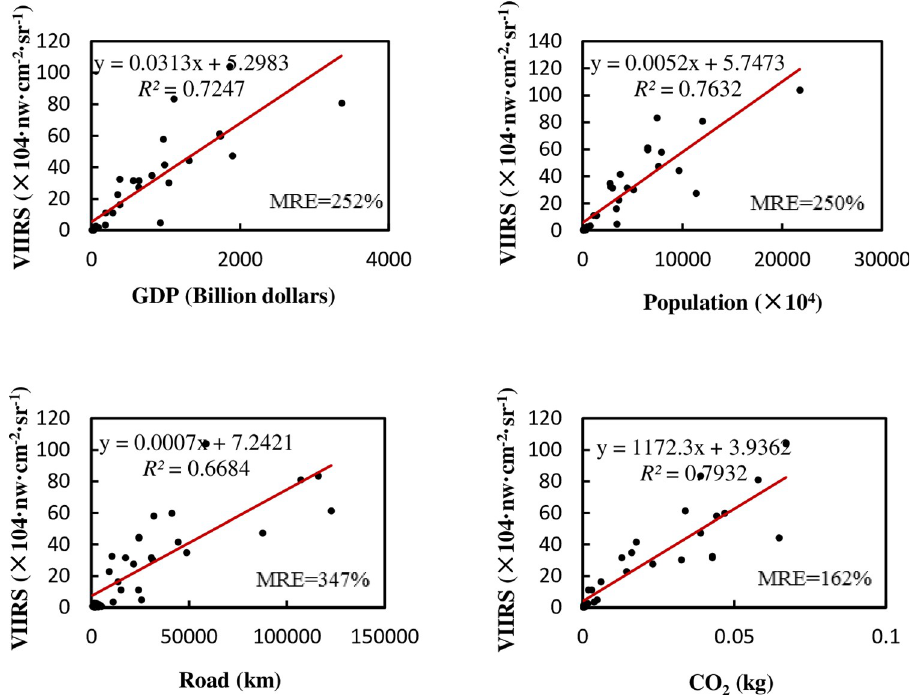
Fig 6. Relationship between total NTL and various elements in Indian state-level administrative